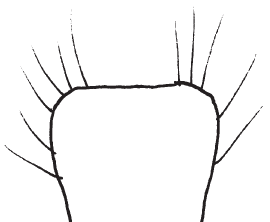
Figure 6: Petiole of the holotype female of C. reburrus , as seen from